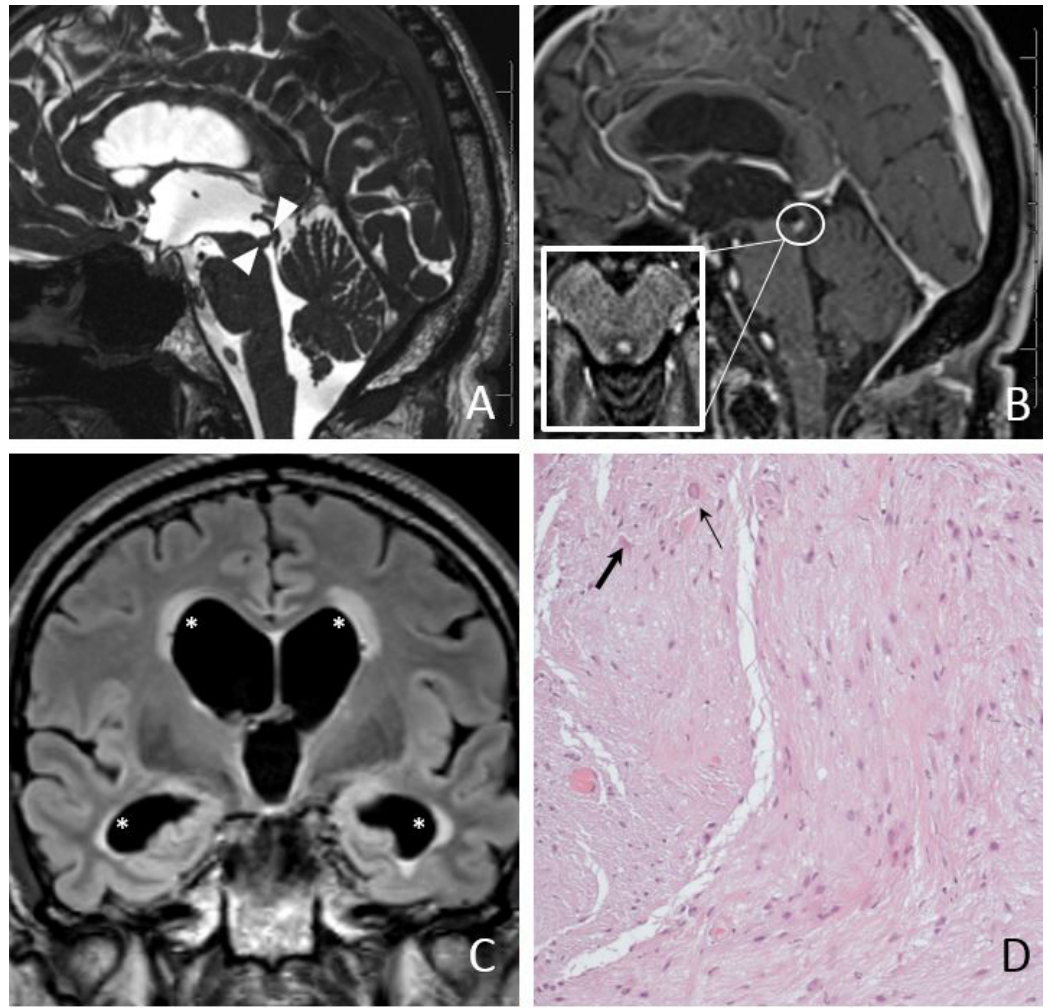
Fig. 1. Case 1. Unusual presentation of an intra-aqueductal aPA causing obstructive hydrocephalus. Sagittal plane reconstructed 3D steady-state (A) and post- gadolinium 3D T1-weighted fast-gradient-echo (B) images, show a small, oval-shaped, enhancing nodule within the mesencephalic aqueduct (arrowheads). Coronal T2-FLAIR (C) demonstrates associated triventricular hydrocephalus (asterisks) with transependymal CSF resorption. Microscopically (D) this tumor exhibits a typical densely fibrillary matrix, comprising spindle cells with elongated nuclei and mild atypia, Rosenthal fibers (thick arrow) and eosinophilic granular bodies (thin